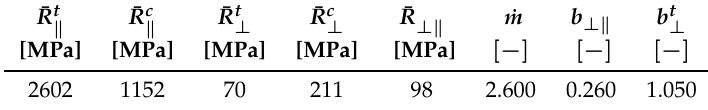
Table 8. Strengths and C UNTZE ’s parameters for a transversal isotropic CRFP with an average FVC of ¯ φ ( m ) =